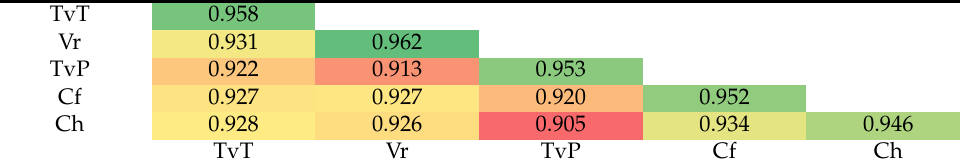
Table 4. Average Dice’s genetic similarity (GS) matrix calculated within and between radicchio biotypes. Colors range from green (highest values) through yellow (mid values) to red (lowest values).